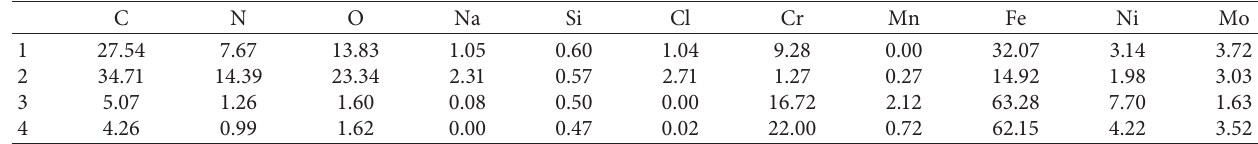
Table 5: Contents distributions of main elements and PREN values in austenite and ferrite phases in stir zone.